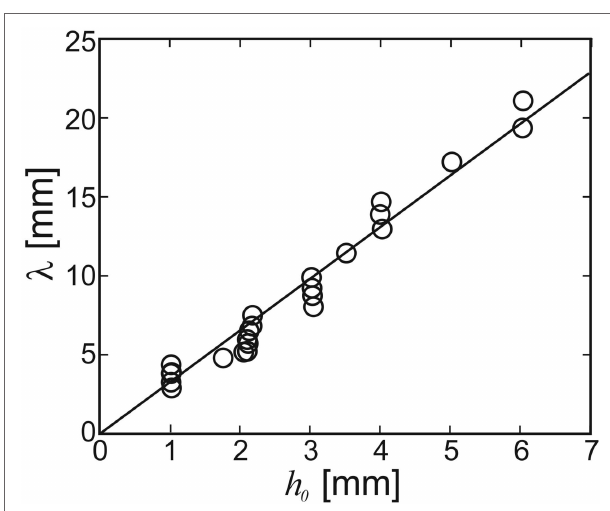
FIGURE 7 | Wavelength of the ripple created through the hydrodynamic instability in PVA films subject to flow . The wavelength does not vary with either the flow speed or the film viscosity. The line shows a fit to the data for (cid:21) = 3.3 (cid:6) 0.3 h 0 , where h 0 is the thickness of the initial PVA film [adapted with modifications from Thomas et al.